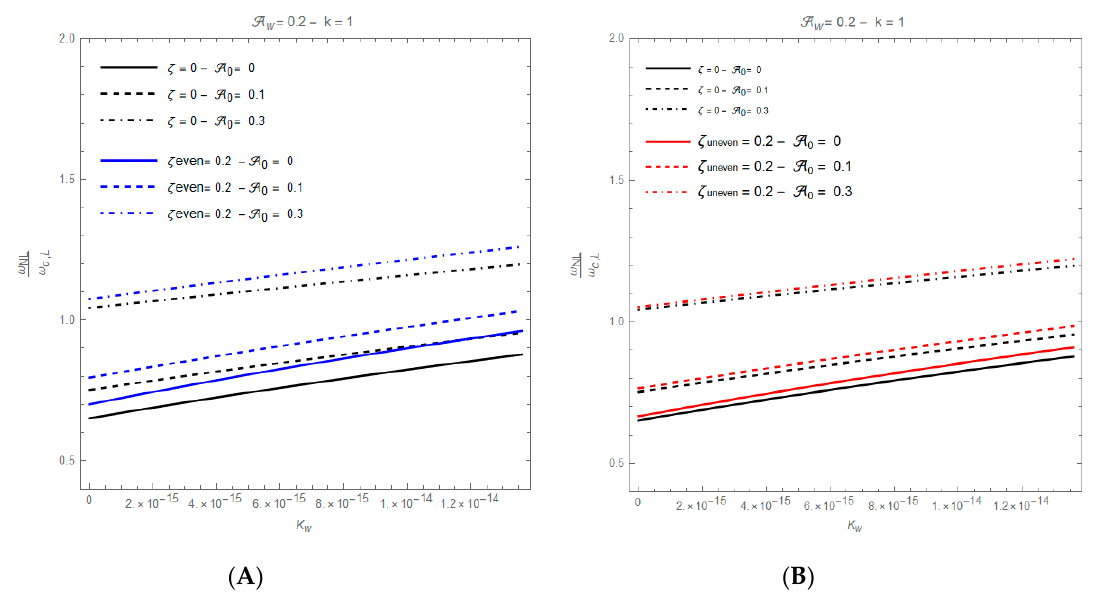
Figure 11. Simply-supported (SS) porous FG nano-beams. Frequency ratio versus Winkler elastic foundation coe ffi cient, A w = 0.2 and k = 1, and di ff erent initial imperfection amplitudes: ( A ) even distribution of porosity, and ( B ) uneven distribution of porosity.